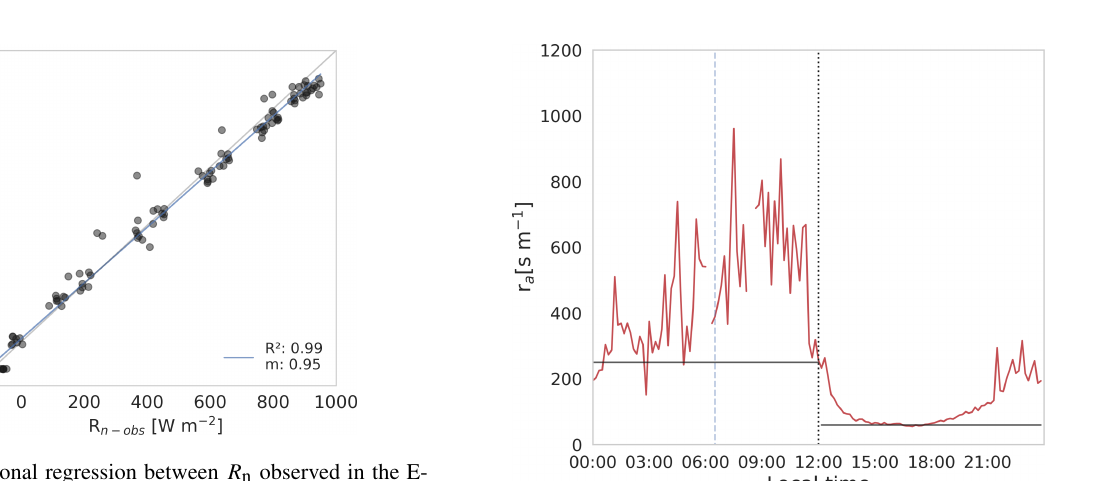
Figure A1. Orthogonal regression between R n observed in the E- DATA field campaign and that modeled using Eq. (A1).